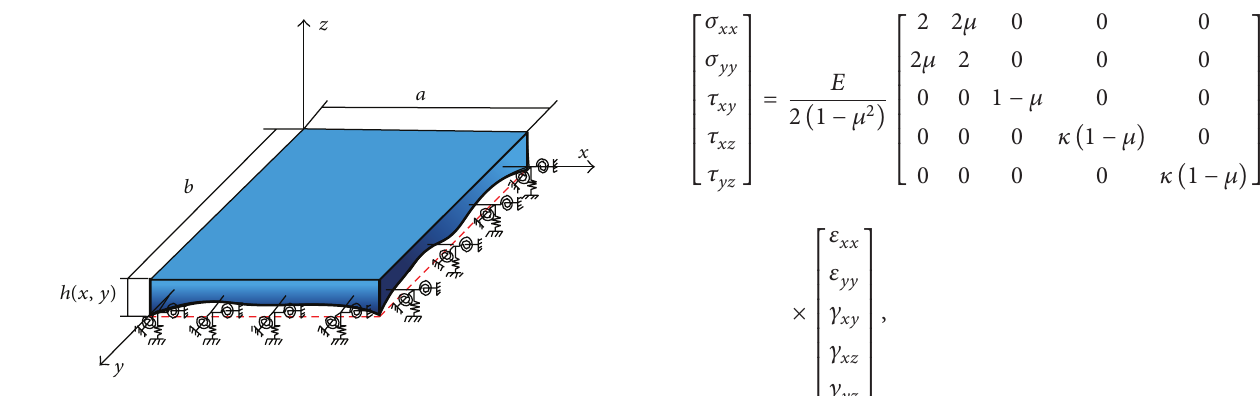
Figure 1: The general elastic boundary conditions of moderately thick rectangular plates with varying thickness in two